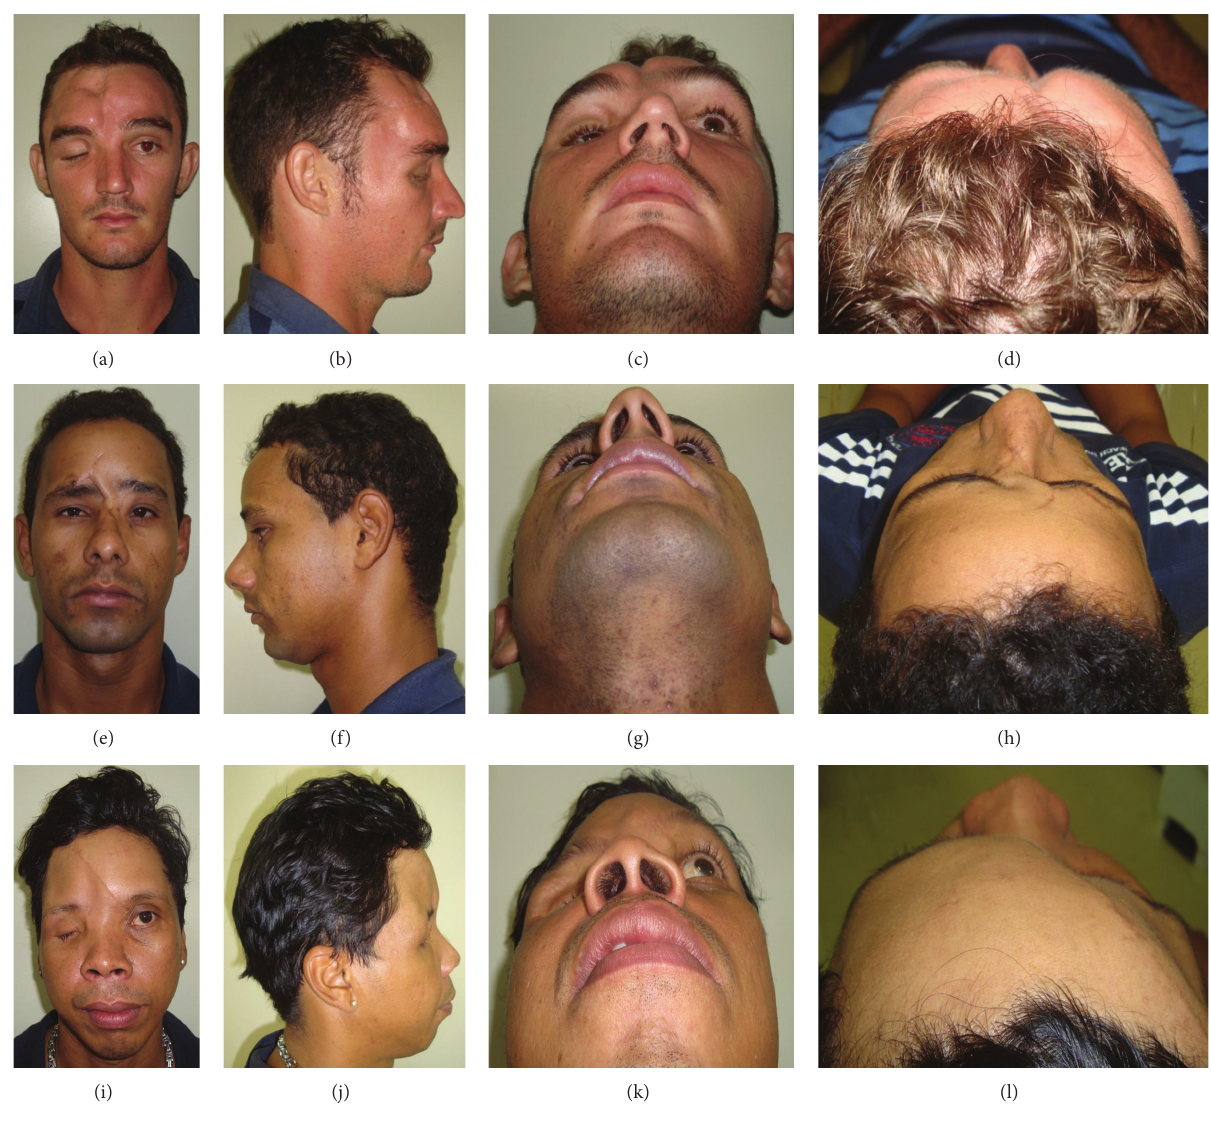
Figure 1: Clinical preoperative evaluation.